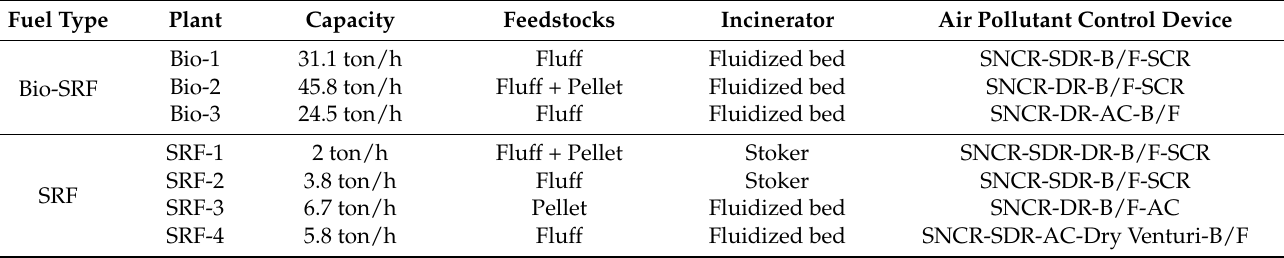
Table 1. Outline of incineration plants for PCDD/DFs